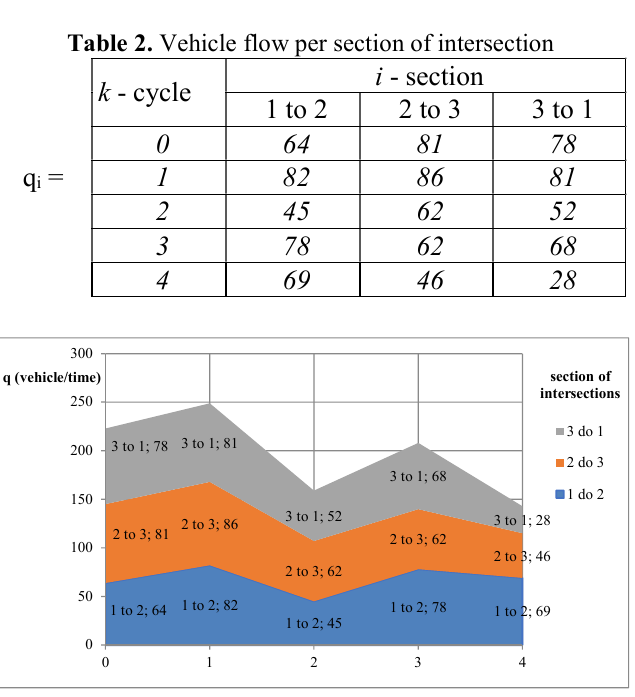
Figure 2. Vehicle flow per intersection section and total for intersection per cycle